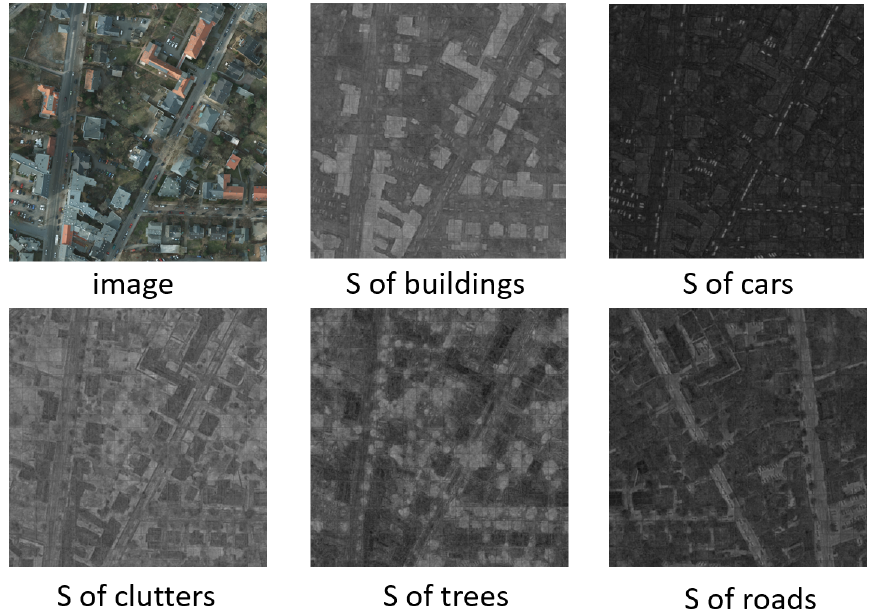
Figure 2. Latent embedding space of buildings, cars, roads, trees and low-vegetation present the latent embedding space of these categories